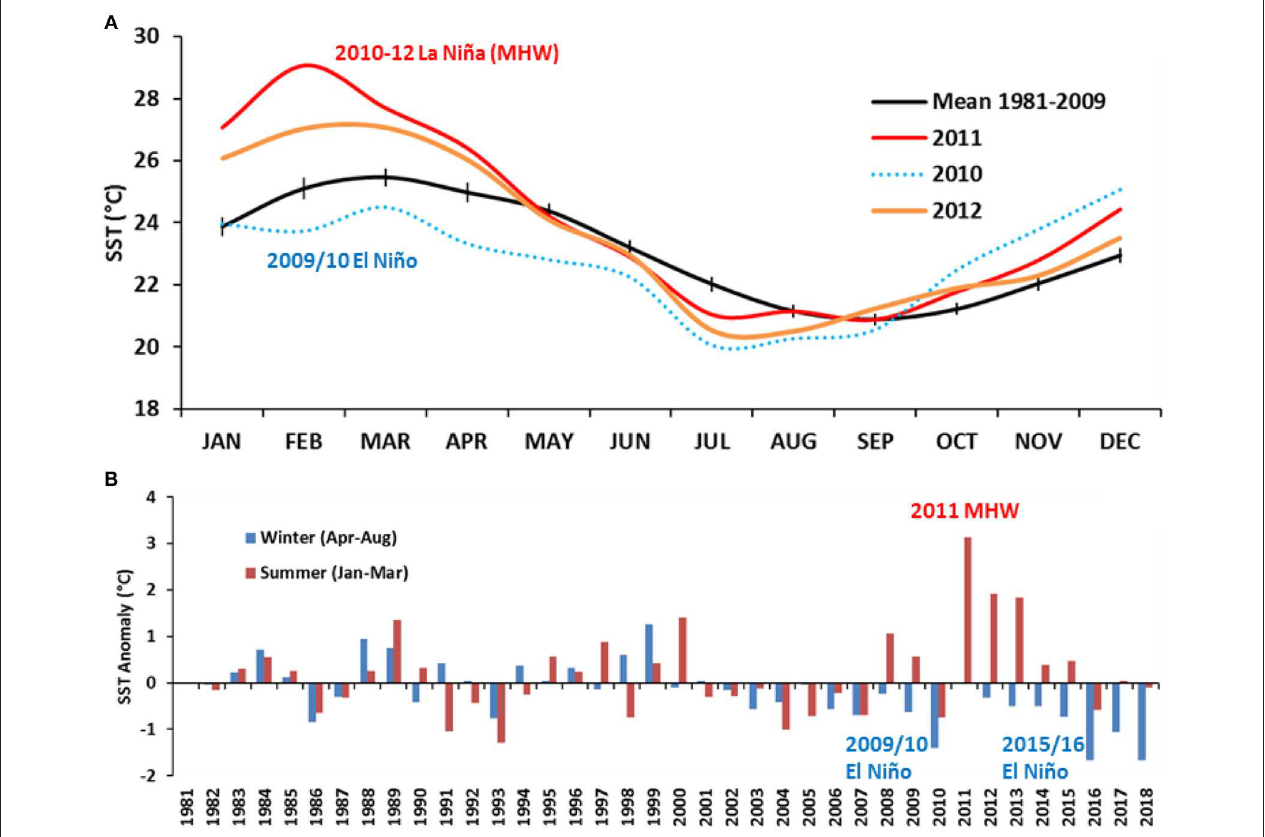
FIGURE 5 | (A) Comparison of the historical (pre-heatwave) mean monthly SST [mean ( ± 95% CI) (1981–2009] and the mean monthly SST between 2010 and 2012 showing a combination of the 2009/10 El Niño phase transitioning to the 2011 MHW as part of the 2010–12 La Niña phase. (B) Mean winter (April to August—blue) and summer (January to March—red) SST anomalies for Shark Bay region from 1982 to 2018, calculated against the 1982–2009 means (representing pre-heatwave